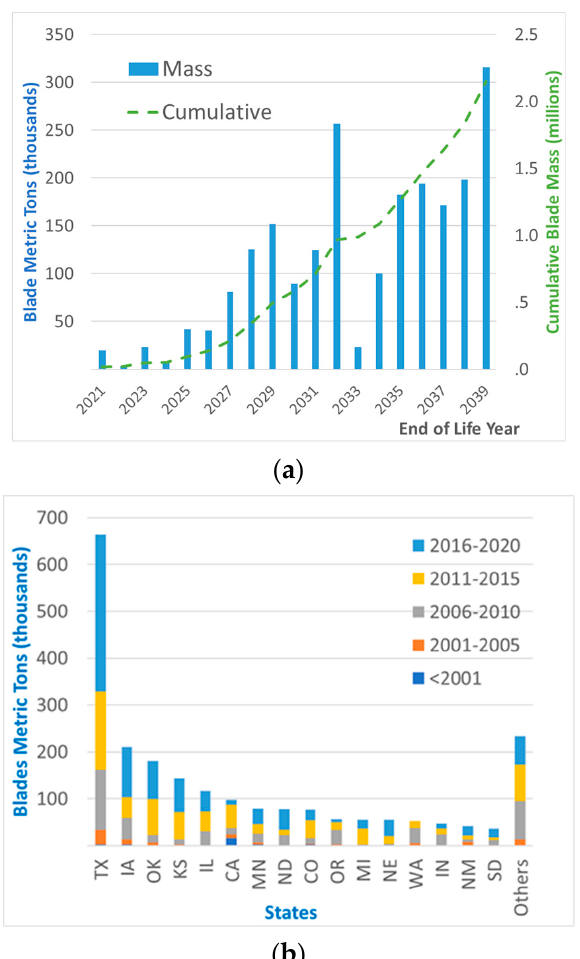
Figure 9. Wind turbine blade mass disposal ( a ) considering disposal year and ( b ) per state with year of installation.